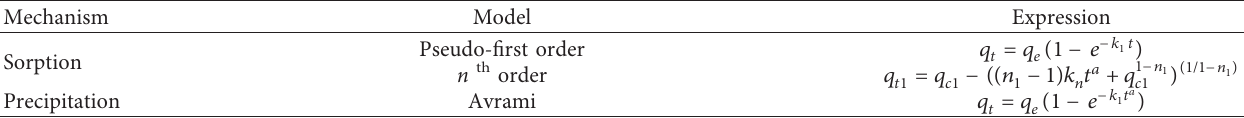
Table 1: Kinetic models used to describe the mechanisms governed the interaction of nickel ions and cement kiln dust.